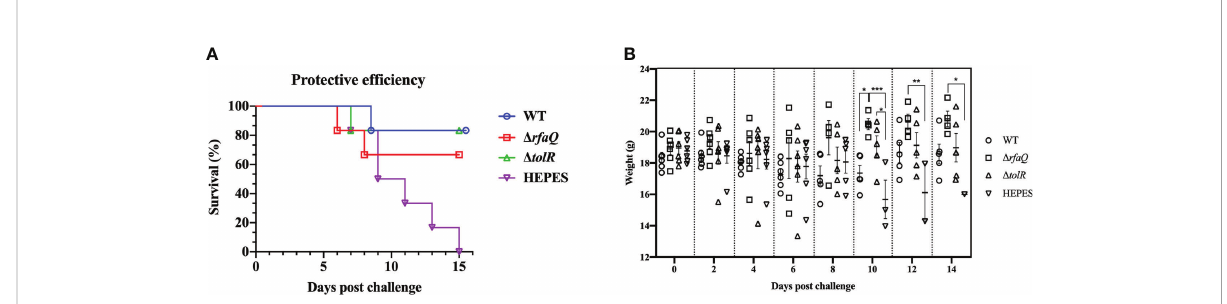
FIGURE 4 Protective ef fi cacy of OMVs produced by three S. Enteritidis strains in mice. Each of the six BALB/c mice in the three groups was i.m. immunized with OMVs from the WT, D rfaQ , and D tolR strains. Another control group were immunized with HEPES buffer. After challenge with CMCC50041, the number of surviving mice was monitored for 15 days. Protective ef fi cacy was determined by the survival rate of mice in each group after challenge with the CMCC50041 strain (A) . Body weights of mice after challenge with the CMCC50041 strain at 2, 4, 6, 8, 10, 12, and 14 dpi (B) . Data are expressed as mean ± SEM. * p ≤ 0.05; ** p ≤ 0.01; *** p ≤